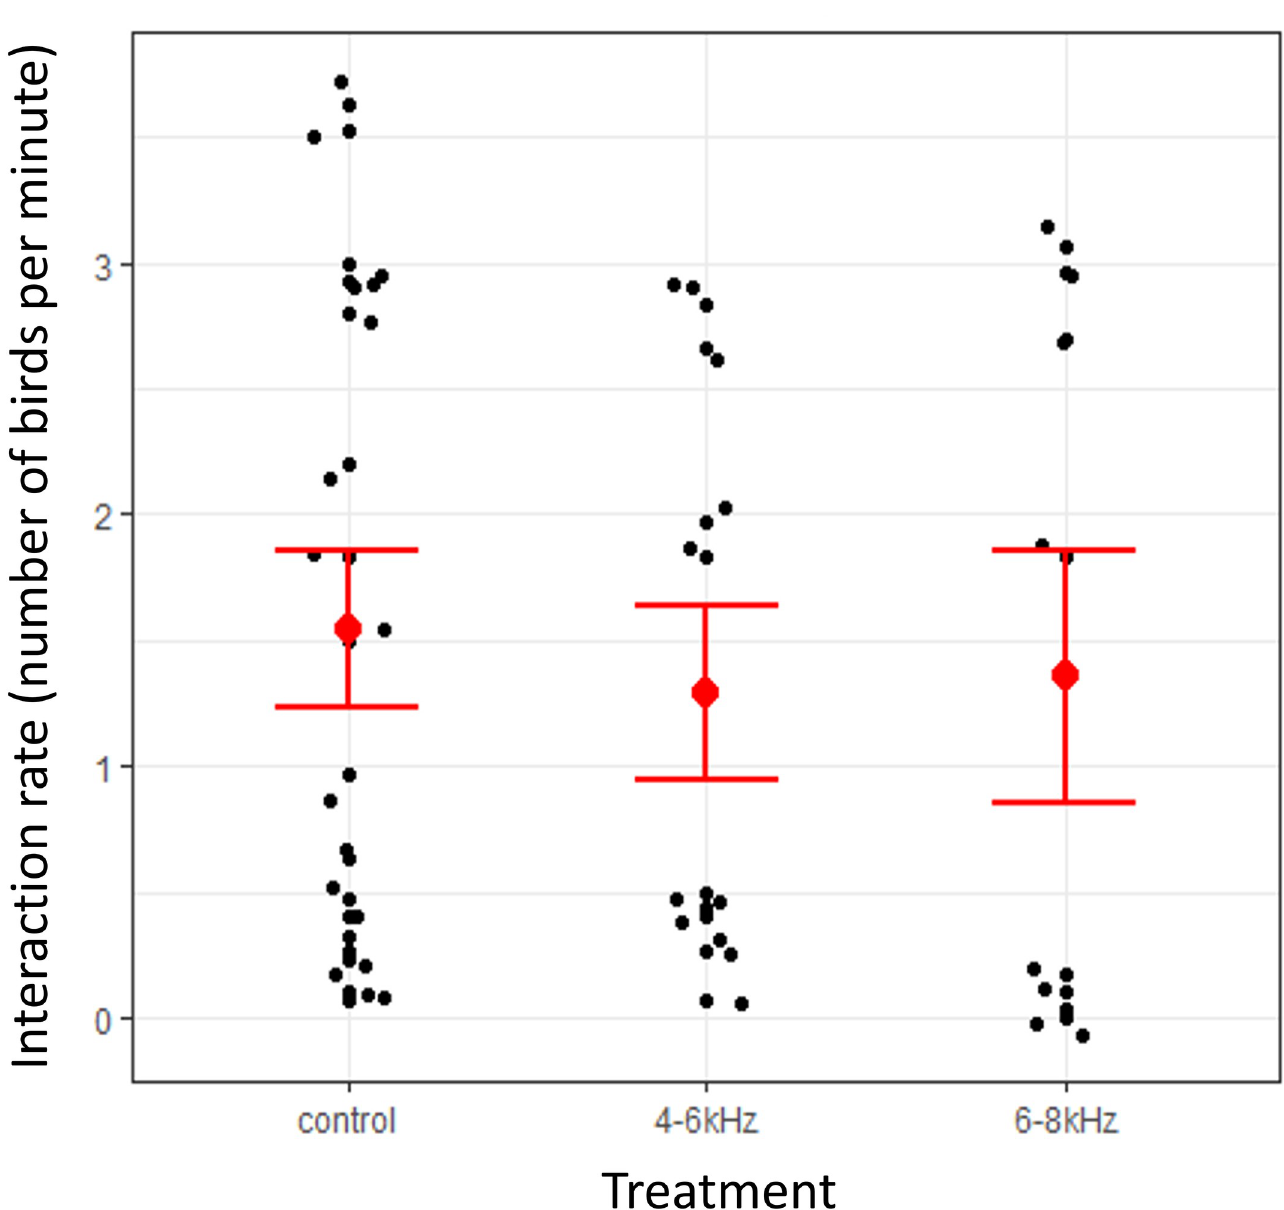
Fig 2. General bird activity around towers by treatment condition. The overall rate of detections by treatment condition. Solid black dots represent detection rates per 30-minute sampling period. Solid red dots and error bars represent mean detection rate ± standard error of the mean.